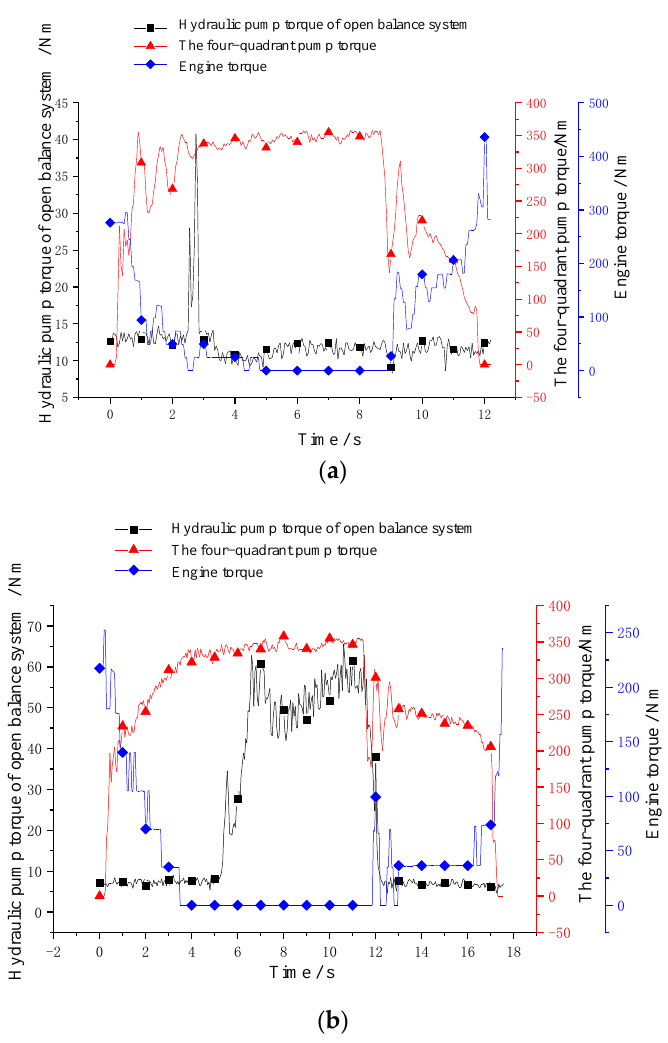
Figure 10. Characteristic curves under different torque. ( a )Torque comparison diagram under condition 3; ( b ) Torque comparison diagram under condition four.